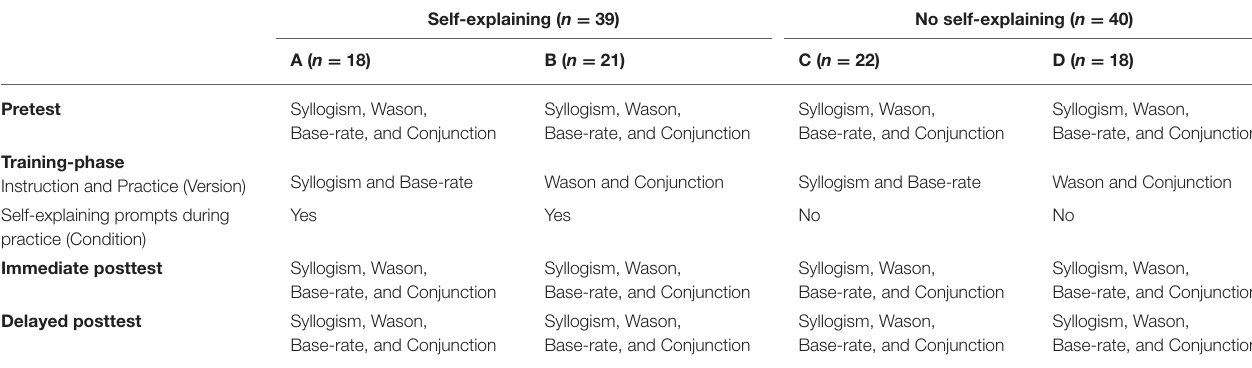
TABLE 1 | Overview of the study